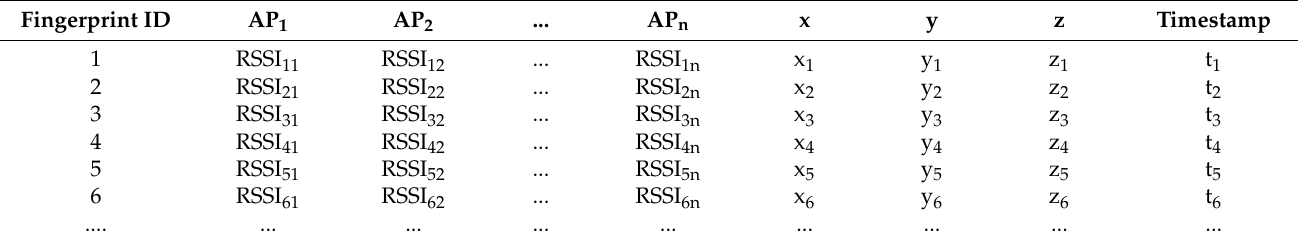
Table 2. 3D temporal fingerprint map